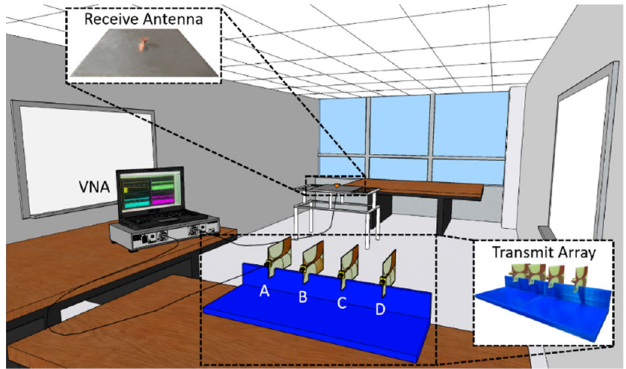
Figure 2. An illustrated view of an office room with the measurement